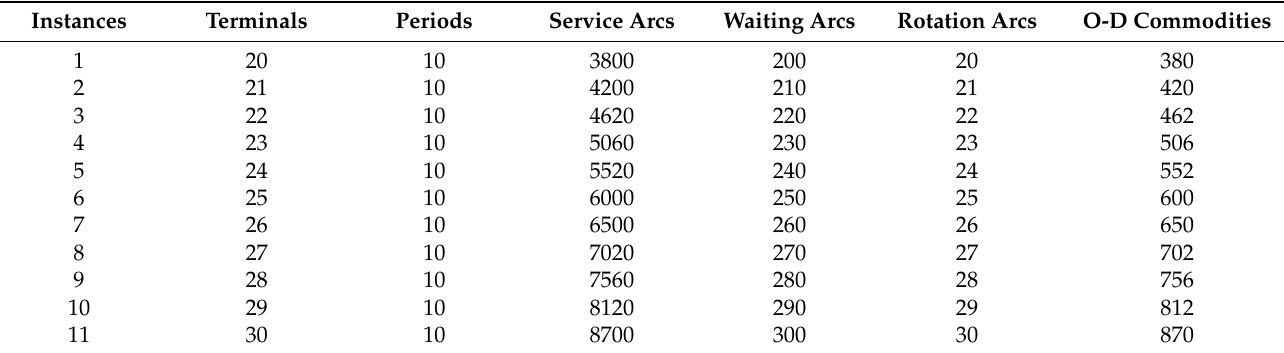
Table 2. Dimensionality of the large-scale